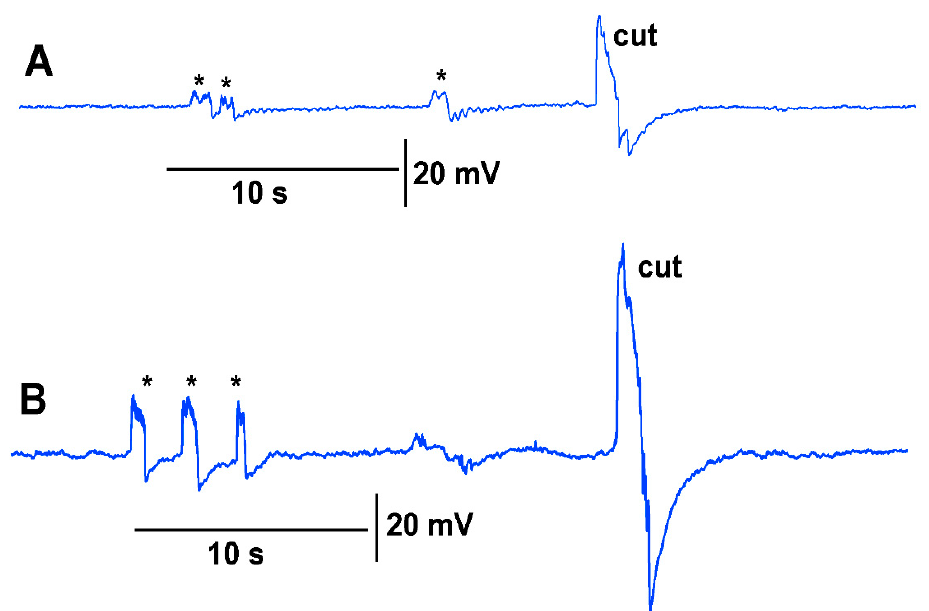
Figure 5. Comparison of impedance using surface contact or tissue penetration of the stem while bending and cutting leaves. Penetration of the plant with the leads shows a more robust signal. ( A ) The two leads of the impedance converter were adhered to the surface of the stem with conductive paint while moving the leaf and cutting a leaf. ( B ) The same plant used for the recording in A was used and the leads were placed within the stem about 1 mm next to the same locations as used for the surface measurement. The asterisk (*) demarcates a bending of the leaf as a test for the effect of movement on the leaf which occurs while cutting a leaf.